Question: Name the type of graph shown.
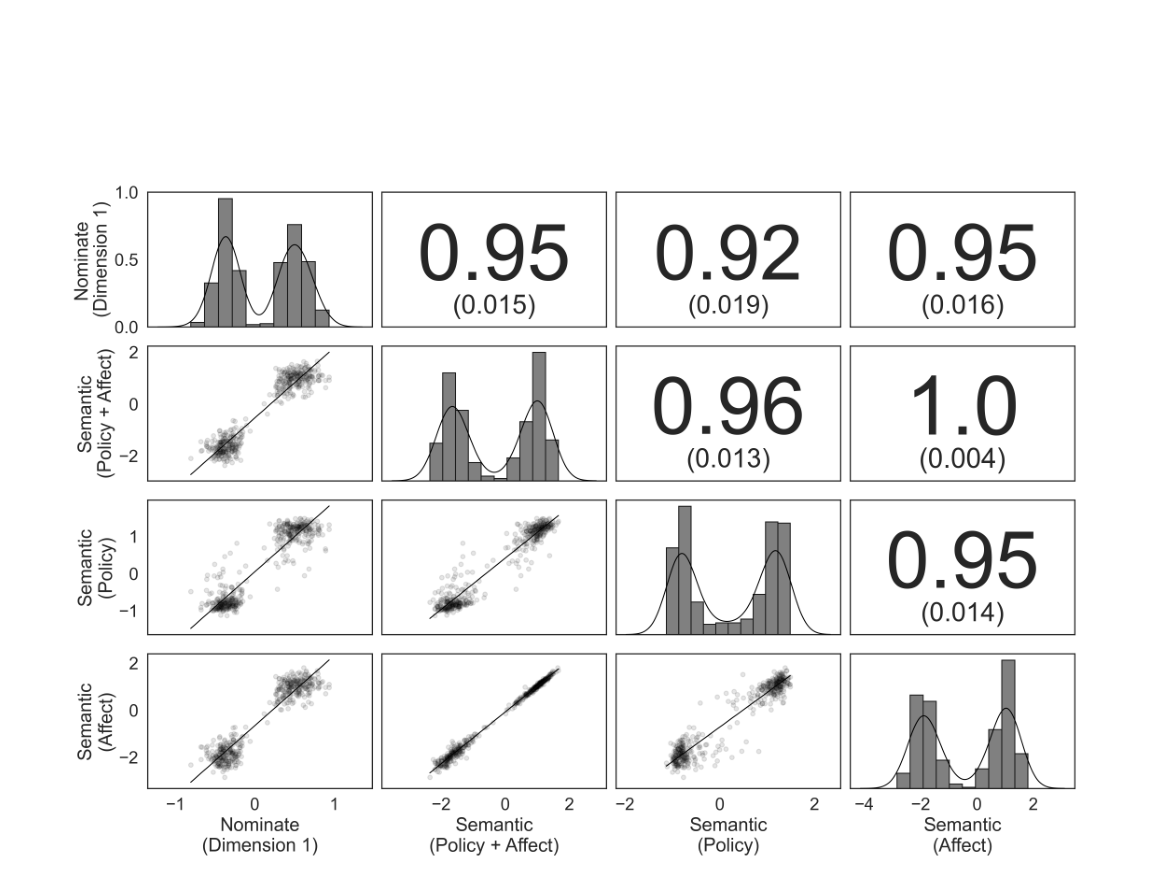
Answer: line